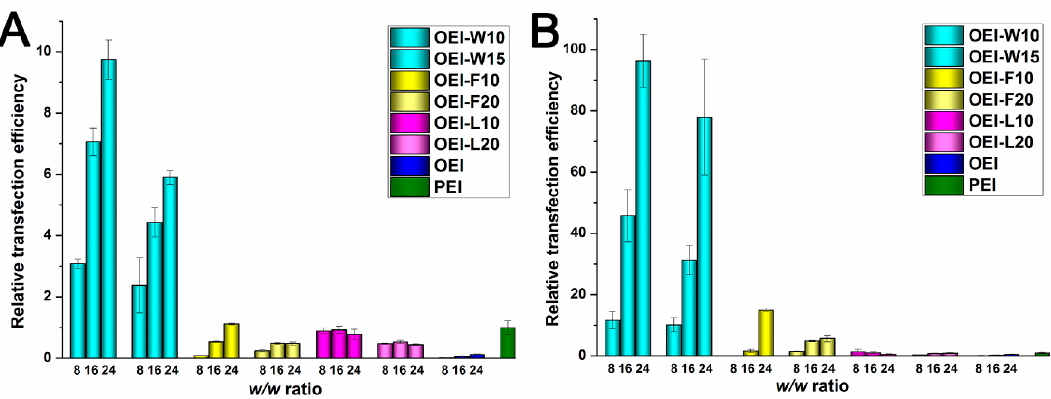
Figure 5. Luciferase gene expression transfected by polyplexes at different weight ratios without ( A ) and with ( B ) the presence of 10% serum in HEK293 cells by normalizing the TE of PEI ( w / w = 1.4) as 1. Data represent mean ± SD ( n = 3).